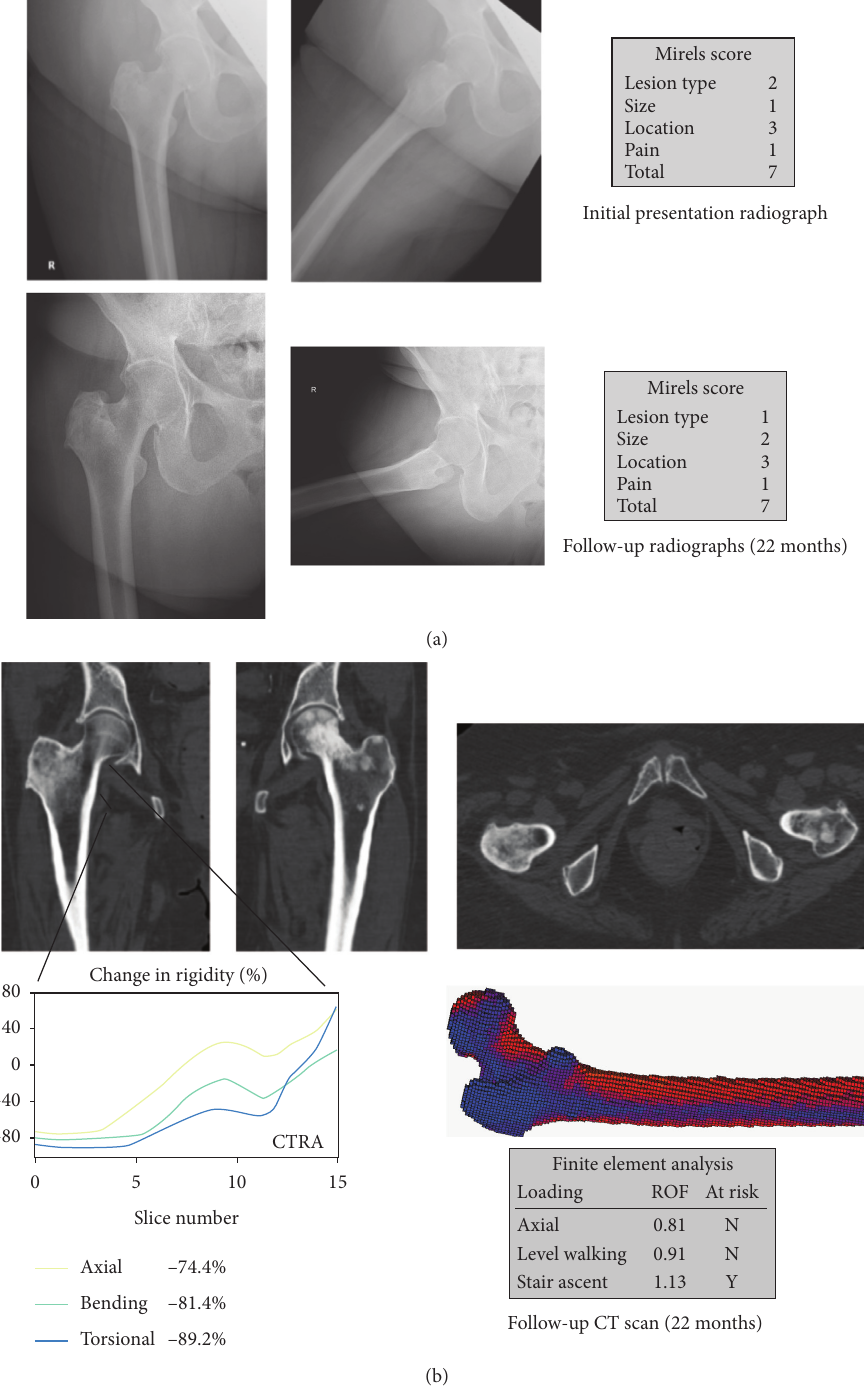
Figure 4: False positive (CTRA+/Fx-) (Case 3, R femur). (a) This is a 59-year-old female with metastatic breast cancer showing a mixed osteoblastic and osteolytic lesion in the right femoral neck. (b) Both CTRA and FEA predicted that the subject would fracture; however, due to a low Mirels’ score and mild pain, she did not undergo prophylactic stabilization